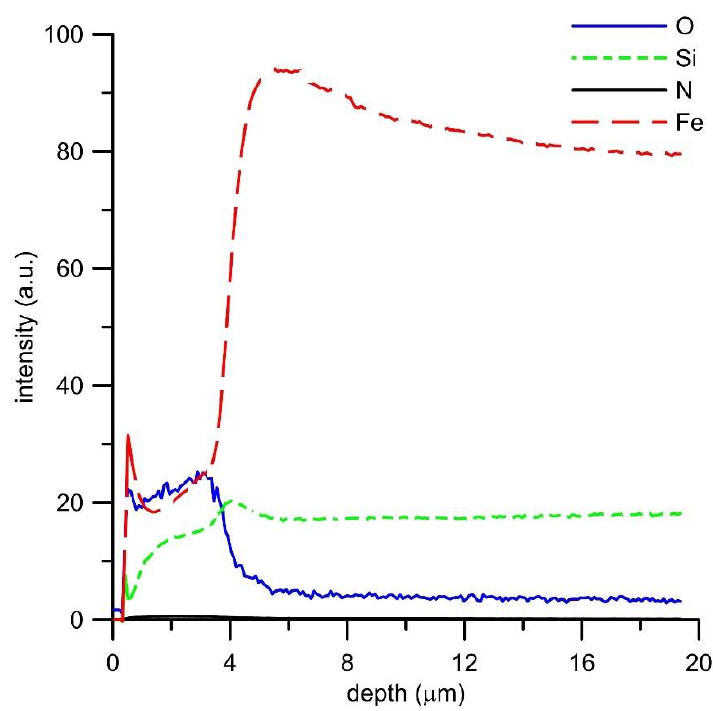
Figure 7. GDOES depth profile of oxidized FeSi14 alloy.